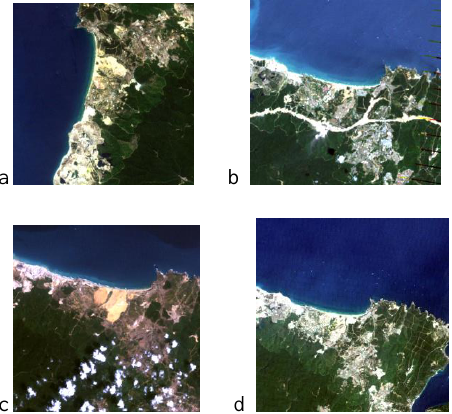
Figure 1: Landsat 7 ETM a) 21 July 2001 and b) 28 July 2015. Landsat 5 TM c) 05/08/1986 d) 31/08/2007. All the images are displayed as true colour composition (RGB= 321).